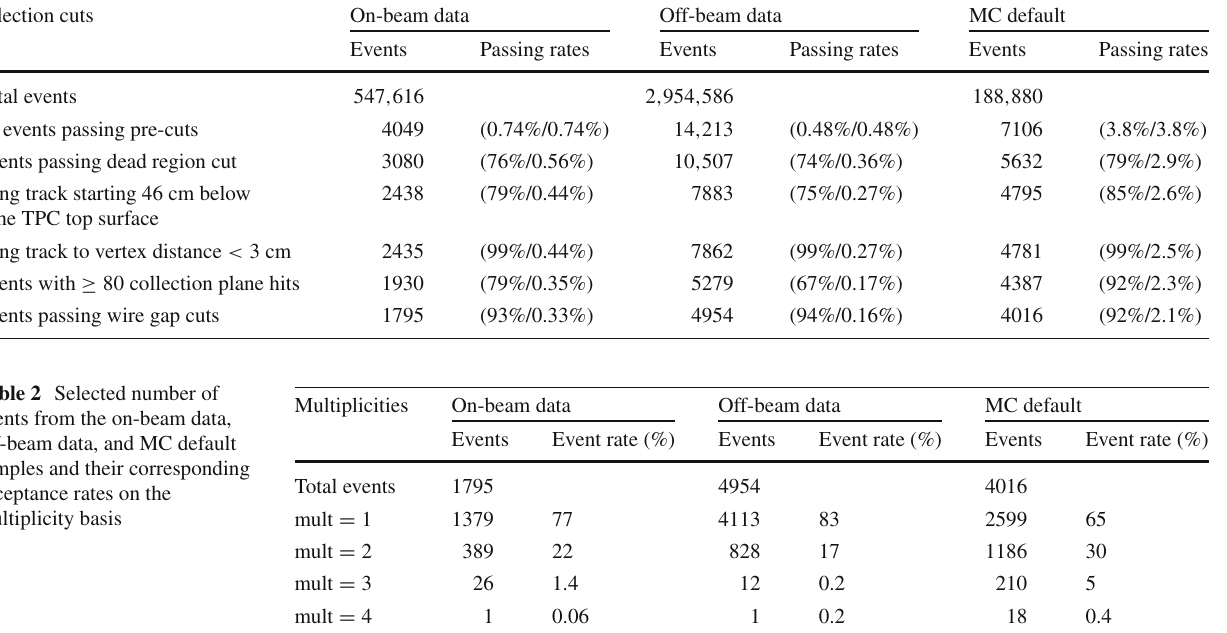
Table 1 Passing rates for event selection criteria applied to on-beam data, off-beam data, and MC default samples. Numbers are absolute event counts. Quantities in parentheses give the relative passing rate